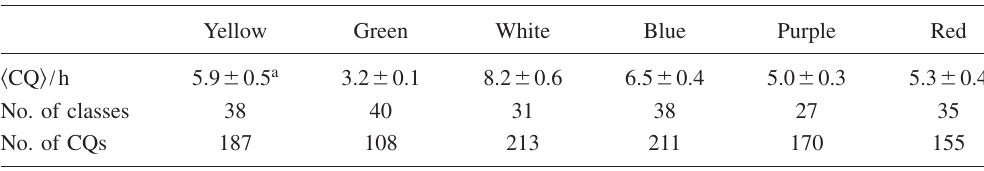
TABLE II. Average number of clicker questions per hour of class. Yellow